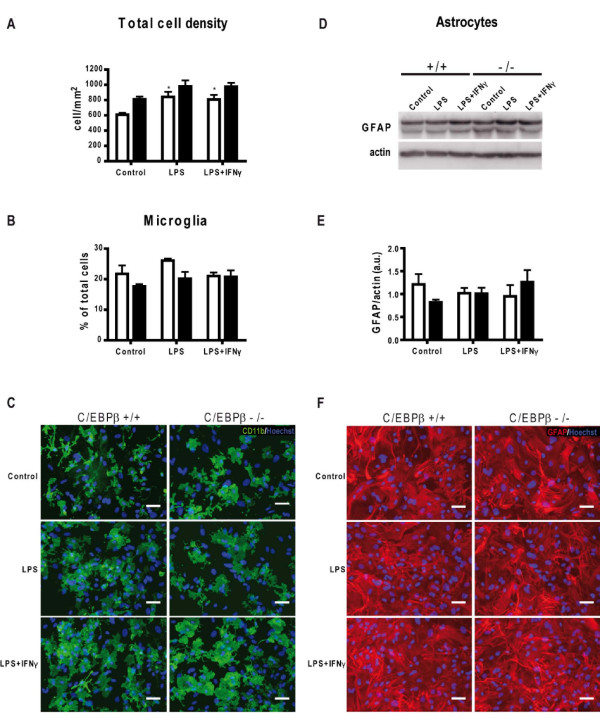
Basic characterization of C/EBPβ-/- mixed glial cultures. Secondary mixed glial cultures from C/EBPβ+/+ (white bars) and C/EBPβ-/- (black bars) show similar total cell numbers and microglial density in control conditions and after 16 h of LPS or LPS+IFNγ. A. C/EBPβ+/+ and C/EBPβ-/- total cell density was estimated by Hoechst-33258-positive nucleus counting. No significant differences were observed between genotypes. Wild-type cultures show a statistically significant increase of cell density after 16 h of LPS and LPS+IFNγ treatment compared to control; C/EPBβ-null cultures show no difference after treatments. Two-way ANOVA, followed by Bonferroni's test was applied. *p < 0.05; compared to C/EBPβ+/+ control. (n = 4). B. Microglia as a percentage of total cells was estimated by CD11b-positive cell counting in C/EBPβ+/+ and C/EBPβ-/- cultures after 16 h treatments with LPS, LPS+IFNγ or vehicle. Significant differences among treatments groups or genotypes are not observed. Two-way ANOVA, followed by Bonferroni's test was applied. (n = 4). C. Secondary mixed glial cultures were immunostained for CD11b (green). Nuclei are stained with Hoechst-33258 (blue). Microglial cell numbers were similar for C/EBPβ+/+ and C/EBPβ-/- cultures. LPS and LPS+IFNγ induced morphological changes in microglial cells in both genotypes. Bar = 50 μm. D. A representative western blot shows levels of GFAP in C/EBPβ+/+ and C/EBPβ-/- mixed glial protein extracts 16 h after vehicle (control), LPS and LPS+IFNγ treatments. β-Actin was used for normalization. E. Densitometric analysis was used to quantify GFAP protein levels versus β-actin in 4 independent western blots in arbitrary units (a.u.). Changes in GFAP protein levels are not observed. Two-way ANOVA, followed by Bonferroni's test was applied. (n = 4). F. Secondary mixed glial cultures were immunostained for GFAP (red) showing a confluent astrocytic layer. Overlapping of astroglial cell bodies makes counting very difficult and imprecise. No differences in astroglial morphology or density among genotypes are observed. Nuclei are stained with Hoechst-33258 (blue). Bar = 50 μm. E. Lack of NOS2 expression in activated astrocytes. C/EBPβ+/+ and C/EBPβ-/- secondary mixed glial cultures were immunostained for GFAP (green) and NOS2 (red), and stained for Hoechst 33258 (blue), after 16 h of LPS+IFNγ treatment. A marked reduction in number of NOS2-positive cells is seen in C/EBPβ-null cultures. The representative merge images show clearly that NOS2-positive cells do not colocalize with GFAP-positive cells. Bar = 50 μm.